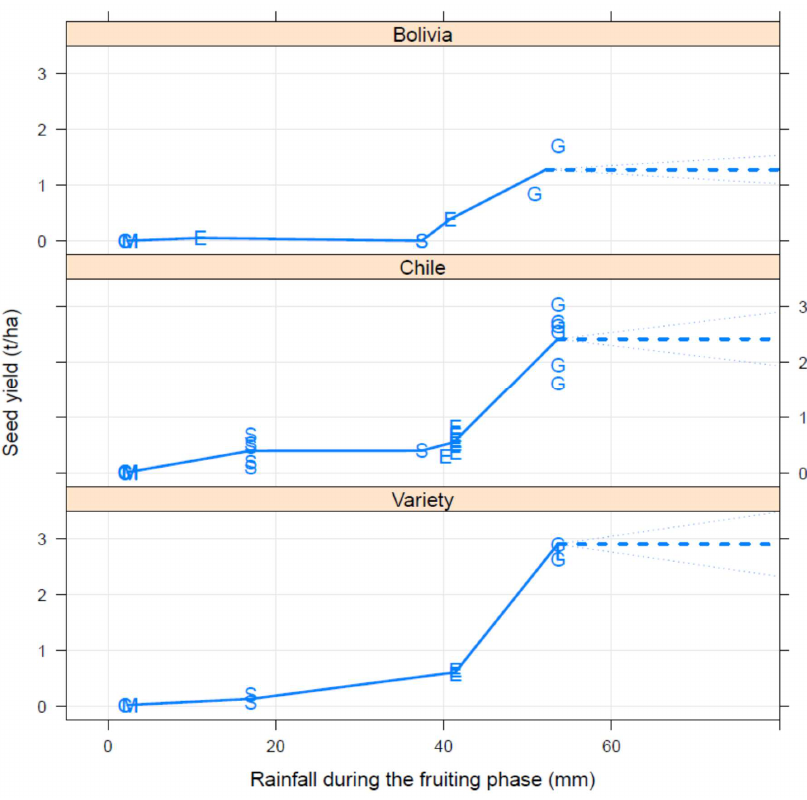
Figure 5. Relationship between rainfall during the seed development stage and seed yield of germplasm from Bolivia, germplasm from Chile and varieties (BEW and JC1) at rain-fed sites in Table 18. Average mean daily temperature and rainfall during the seed development stage, average mean daily temperature during the first 30 days after commencement of flowering, long term average rainfall during the seed development stage and long-term growing season rainfall for a range of varieties and germplasm lines tested at rain-fed sites in Western Australia (a range is listed where flowering times for individual varieties and germplasm lines varied).